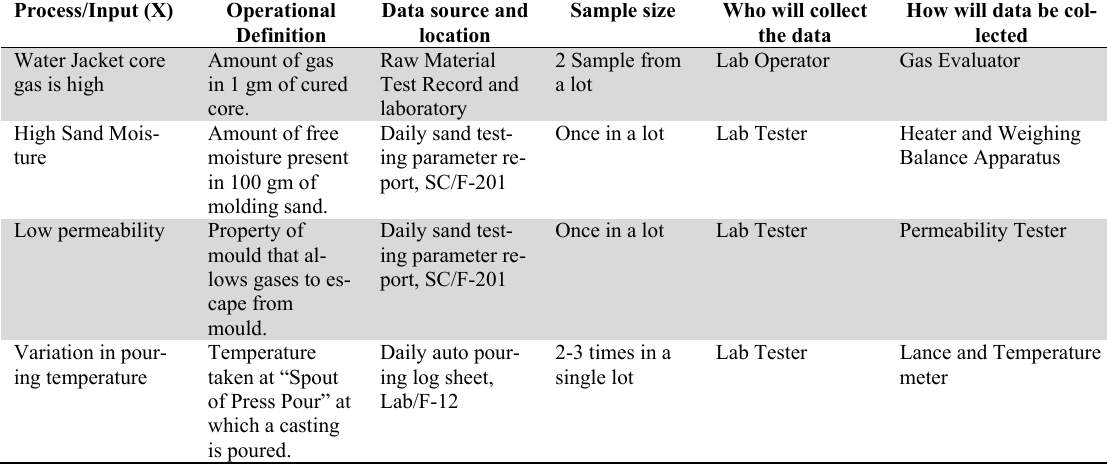
Data Measurement Plan